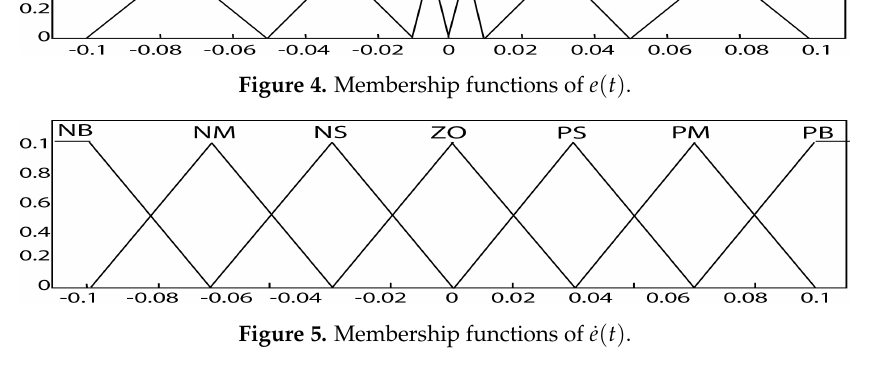
Figure 5. Membership functions of ˙ e ( t ) .